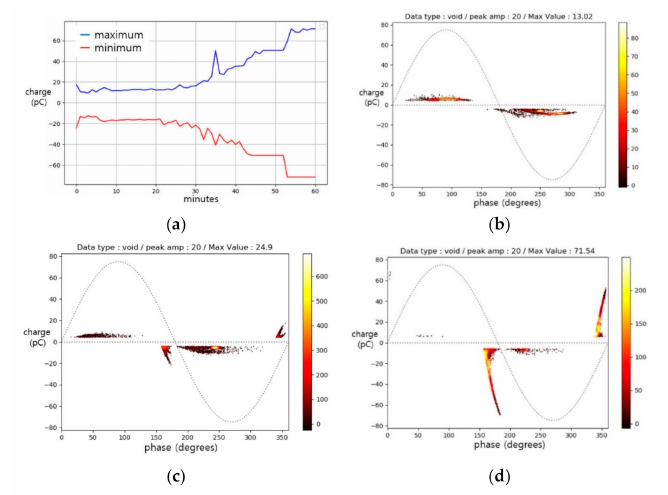
Figure 7. Analysis of the LEMKE void-type PD ( a ) the maximum and minimum values of the pule